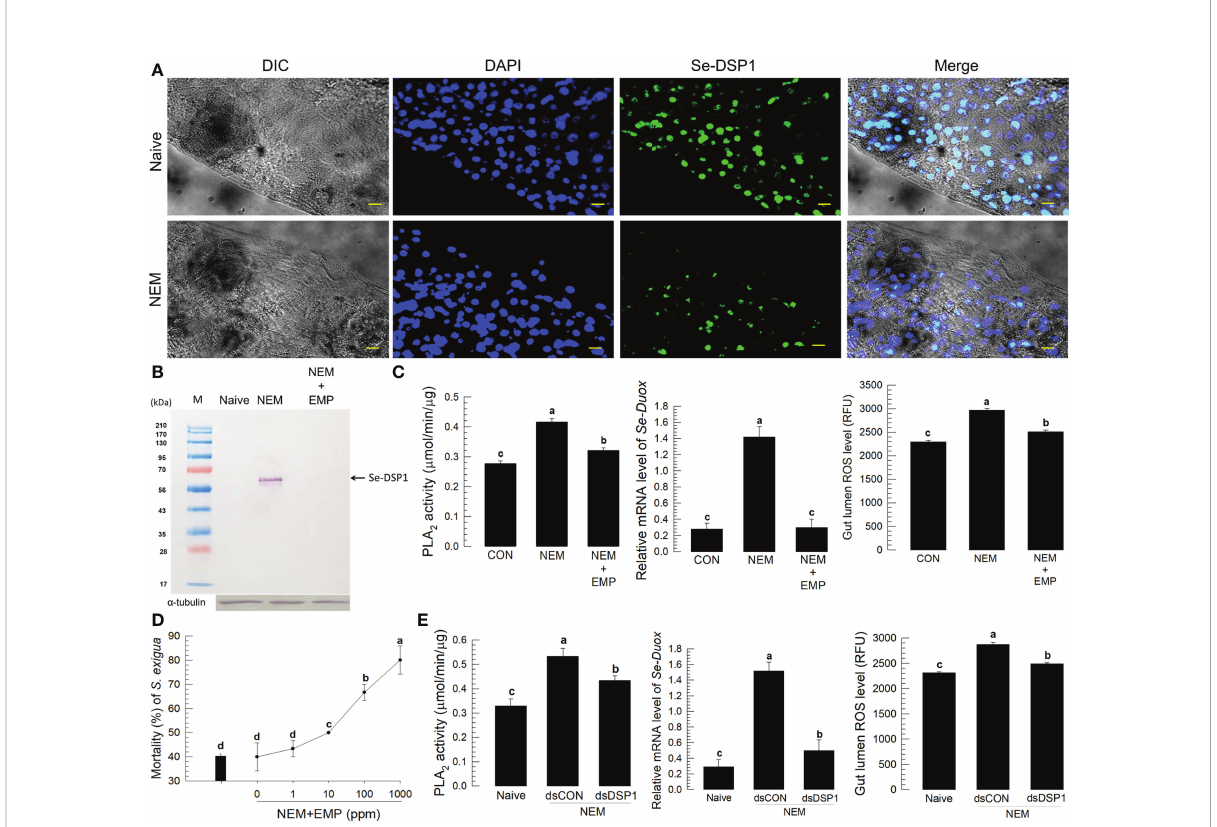
FIGURE 2 Release of Se-DSP1 from the midgut epithelium to defend the entomopathogenic nematode ( ‘ NEM ’ ) infection. Each L5 larva of S . exigua was fed with 80 IJs of S . feltiae . (A) Nuclear localization of Se-DSP1 in the midgut epithelium of S . exigua . An immuno fl uorescence image was obtained by staining Se-DSP1 using a speci fi c antibody labeled with FITC and nuclei with DAPI. ‘ DIC ’ represents differential interference contrast. The scale bar represents 10 µm. (B) A western blotting showing release of Se-DSP1 upon the nematode infection into plasma, which was obtained 8 h after the nematode treatment. 3-Ethoxy-4-methoxyphenol ( ‘ EMP ’ , 1,000 ppm) was treated along with the nematodes. a -Tubulin was stained as a control to con fi rm the equal amount of protein loading. (C) Effect of Se-DSP1 release on PLA 2 activity in plasma, Se-Duox expression in the epithelium, and ROS level in the gut lumen. (D) Enhancement of the nematode (80 IJs/larva) virulence with the addition of EMP against L5 larvae of S . exigua . Mortality was assessed at 48 h after the nematode treatment. (E) Effect of PLA 2 activity induced by Se-DSP1 release on Se-Duox expression and ROS production. RNAi was performed by injecting dsRNA (1 µg) speci fi c to Se-DSP1 . The nematode treatment was followed at 24 h after the dsRNA injection. At 8 h after the nematode treatment, Se-Duox expression and ROS production were assessed. Each treatment was replicated three times. Different letters above the standard error bars indicate signi fi cant differences among means at Type I error = 0.05 (LSD